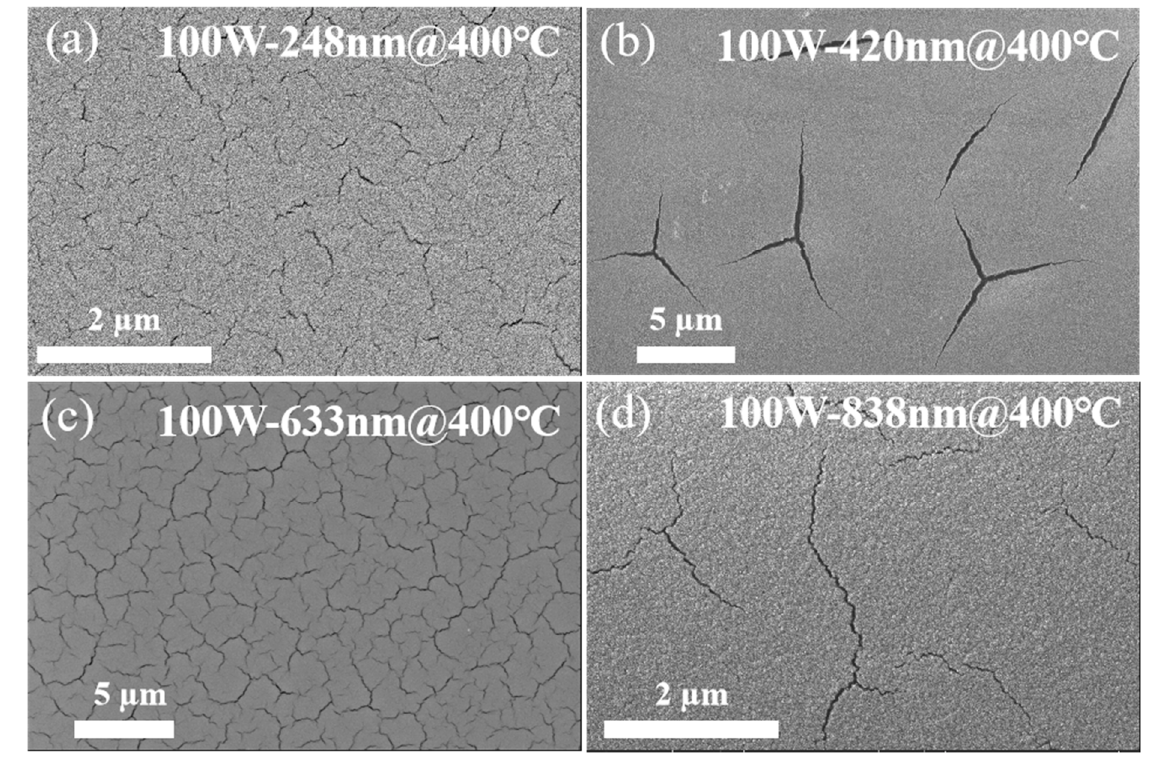
Figure 5. ( a – d ) are the SEM images of Y 2 O 3 films (samples 1-1 to 1-4) annealed at 400 °C.